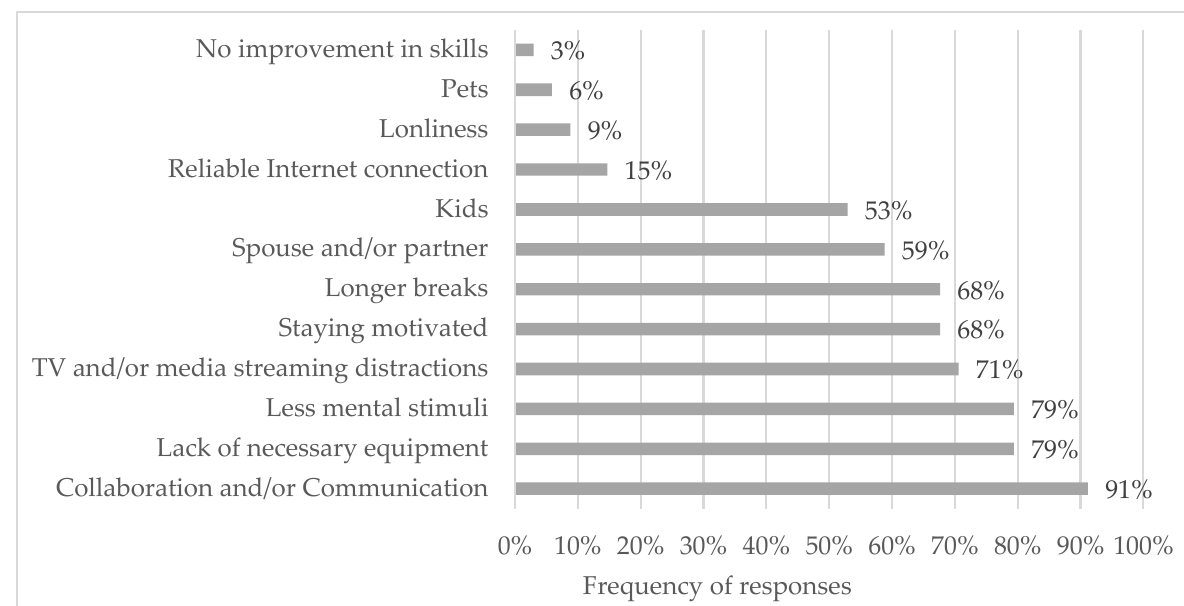
Figure 5. Relative frequency distribution of responses to “Top struggles associated with remote work”.